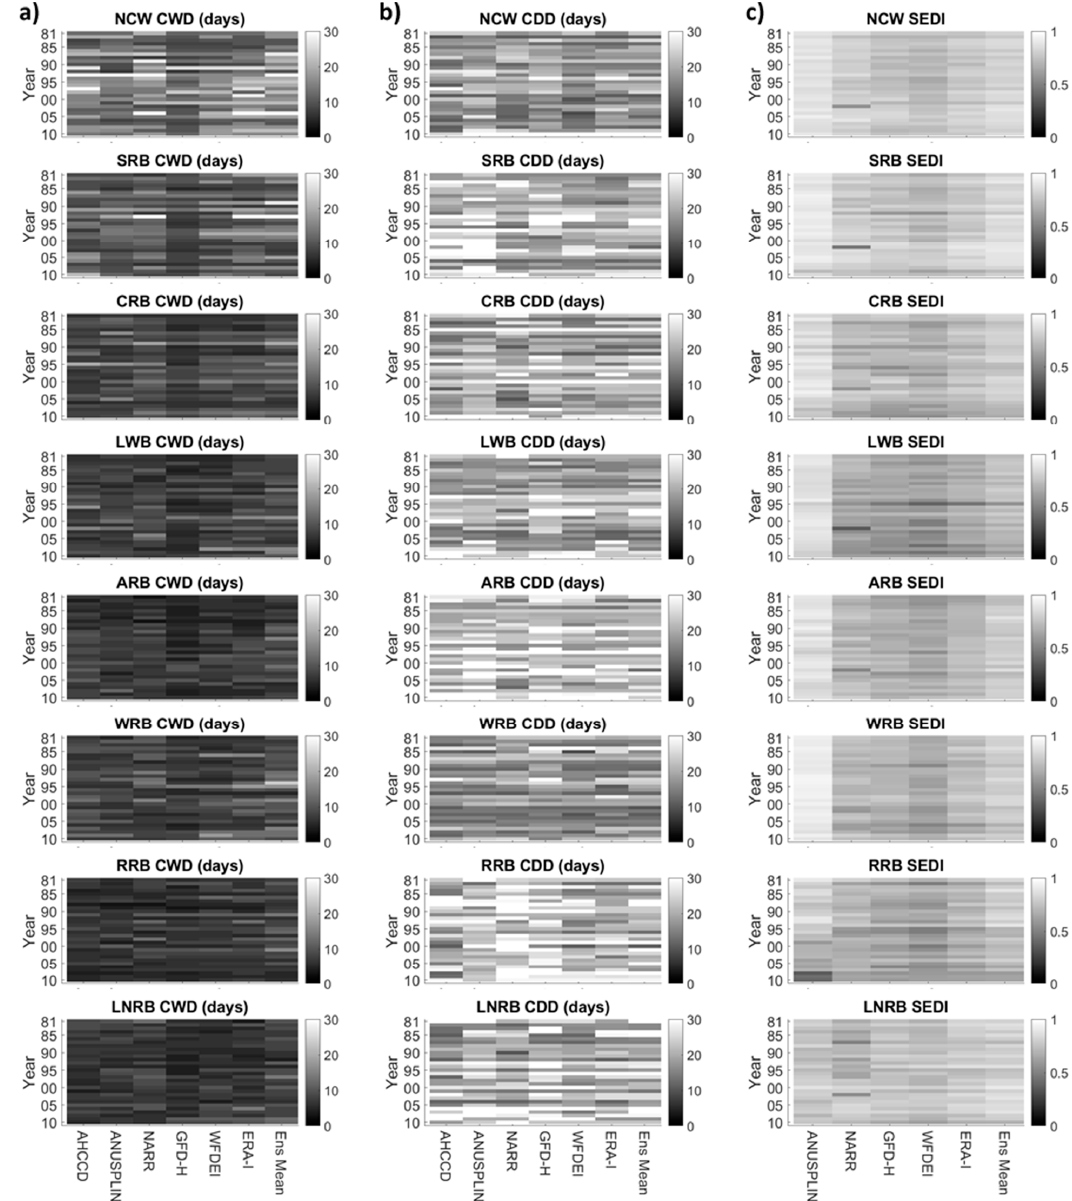
Figure 4. Spatially aggregated daily precipitation extreme indices (yearly periods) in each sub-basin (1981–2010). ( a ) CWD, ( b ) CDD, and ( c ) SEDI.